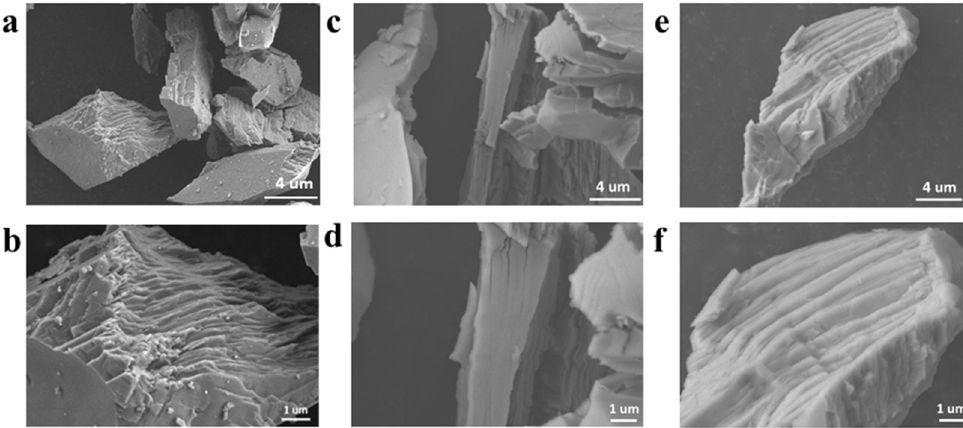
Figure 3. SEM images of CMO-8 ( a , b ); CMO-9 ( c , d ); CMO-1 ( e , f ).